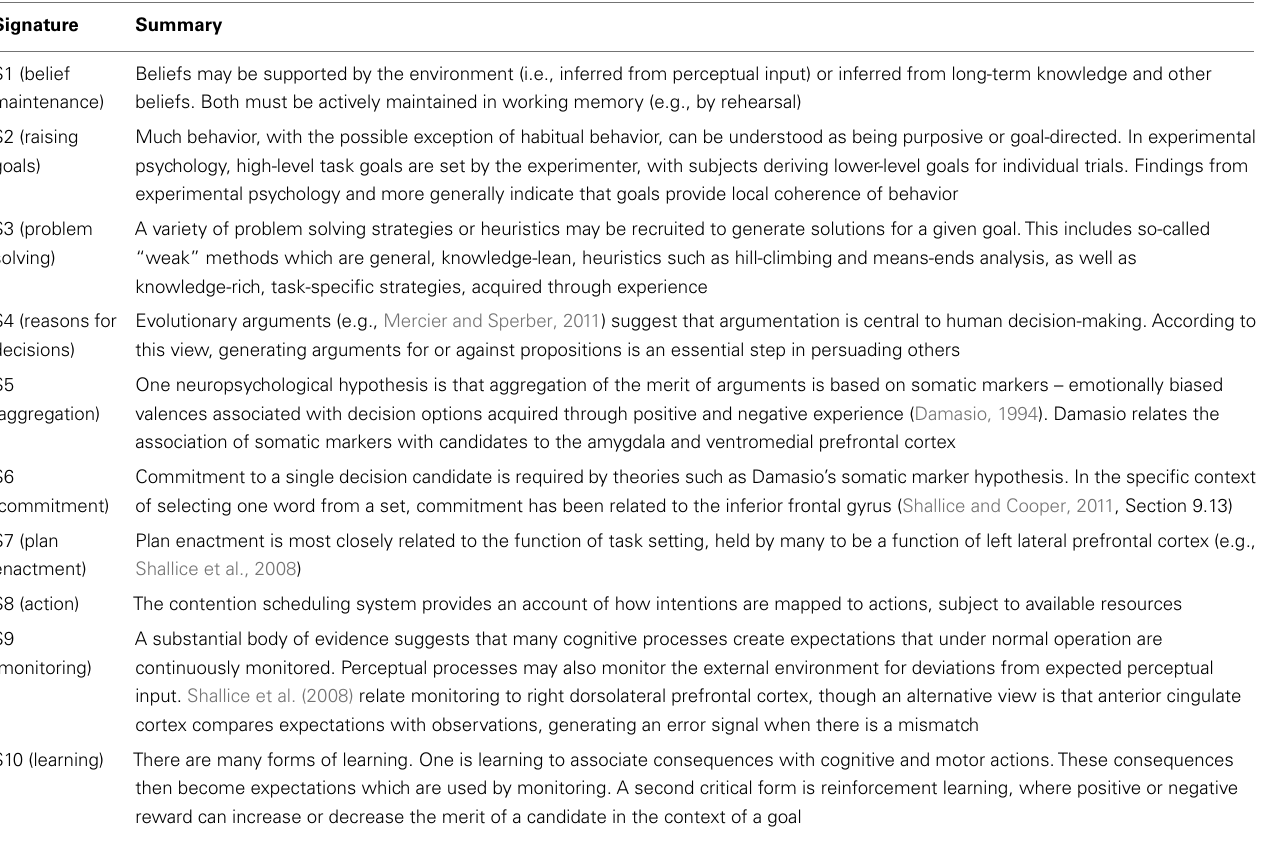
Table 3 | Some relationships between the canonical functions and selected evidence from cognitive psychology and cognitive neuroscience.